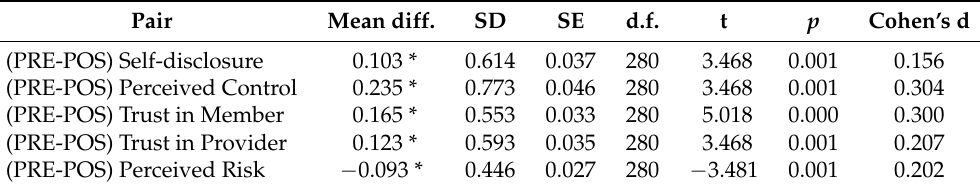
Table 4. Paired sample t